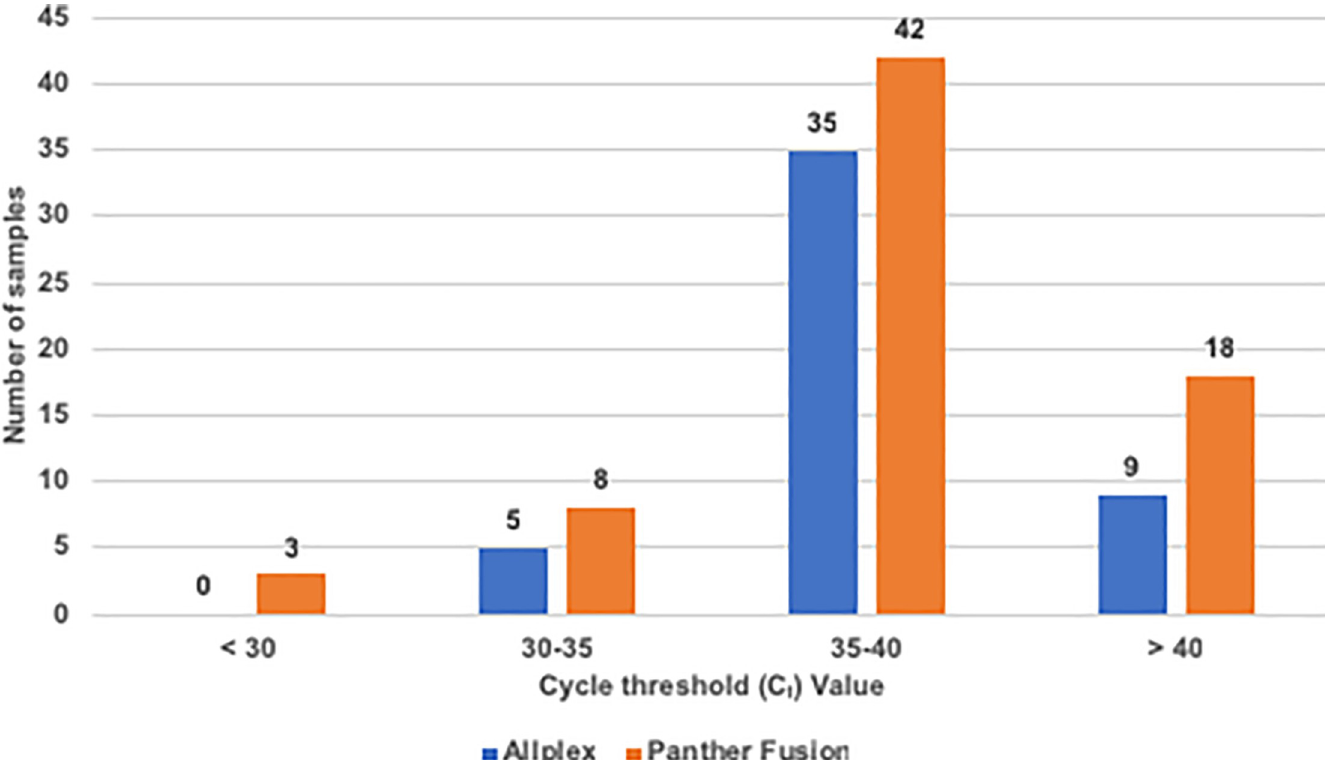
Fig 1. Distribution of samples with discordant results according to their cycle threshold (C t ) values.